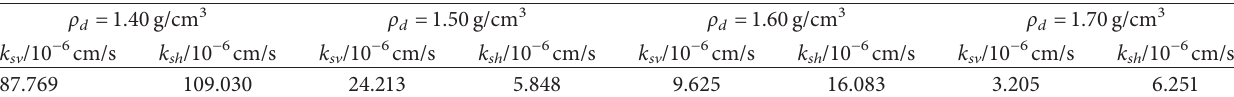
Figure 2: SLB-1 triaxial permeameter apparatus. Table 2: Permeability coefficient of saturated compacted loess.